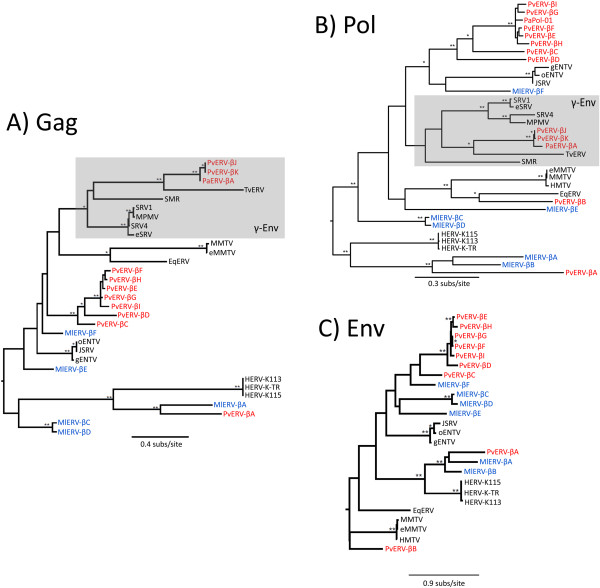
Phylogenetic relationships of bat and non-bat betaretroviruses. Maximum likelihood phylogenetic trees of (A) Gag, (B) Pol, and (C) Env amino acid sequences. Bootstrap values <70% are not shown, and branch lengths are drawn to a scale of amino acid substitutions per site. Bootstrap values are denoted as ** >90%; * >70% and < 90%. The trees are midpoint rooted for purposes of clarity only. βERV proteins of P. vampyrus and P. alecto are highlighted in red text. βERVs of M. lucifugus are highlighted in blue text. The clades within the Gag and Pol trees highlighted with a grey background (γ-Env) contain betaretroviruses whose Env sequence is not sufficiently closely related to the Env of other betaretroviruses to be included in the Env tree.